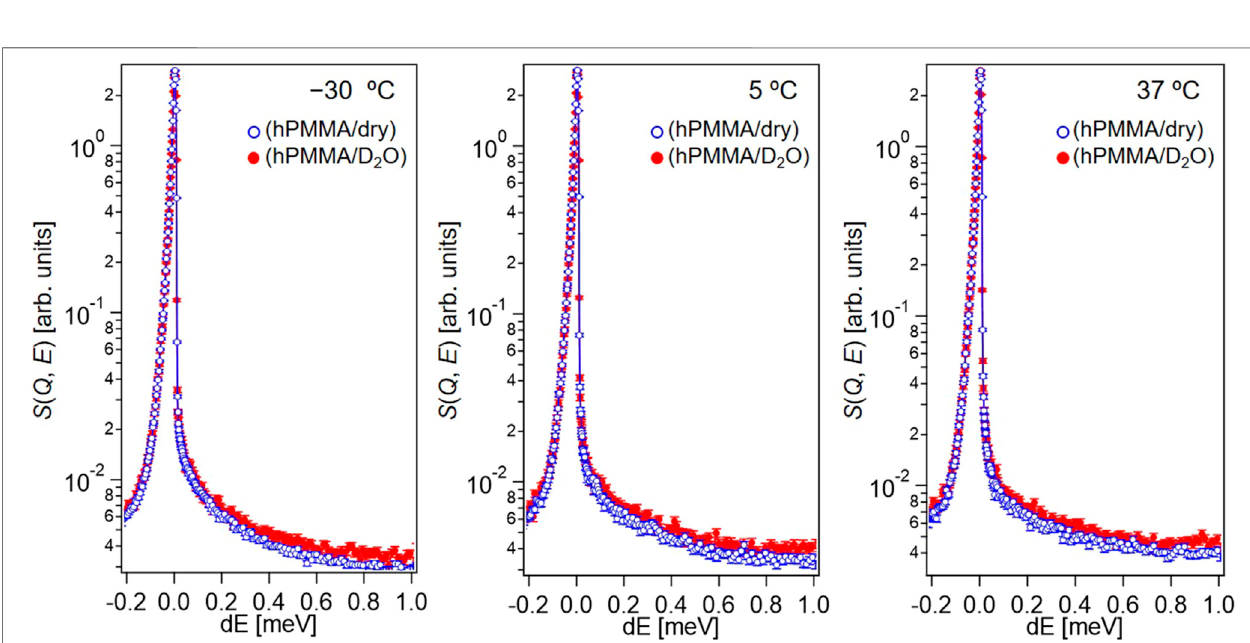
FIGURE 2 | QENS pro fi les of hPMMA/D 2 O (red closed circles) and dry hPMMA (blue open circles) at Q ∼ 1 Å − 1 of in the high- fl ux mode at − 30, 5, and 37 ° C.